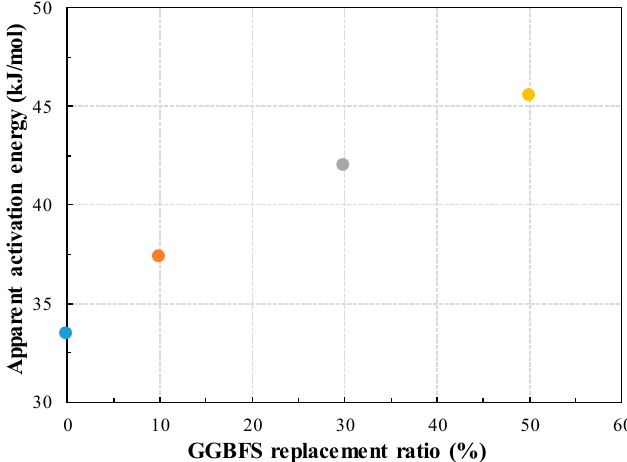
Figure 7. Apparent activation energy according to the GGBFS replacement ratio.